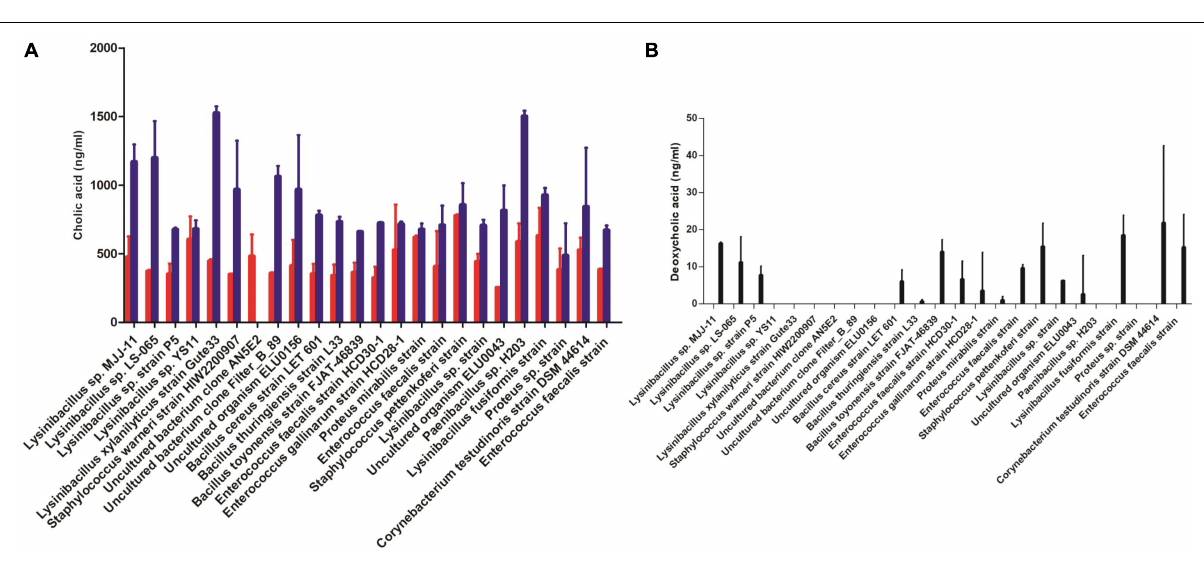
contain bacteria (Jimenez et al., 2014). In our previous